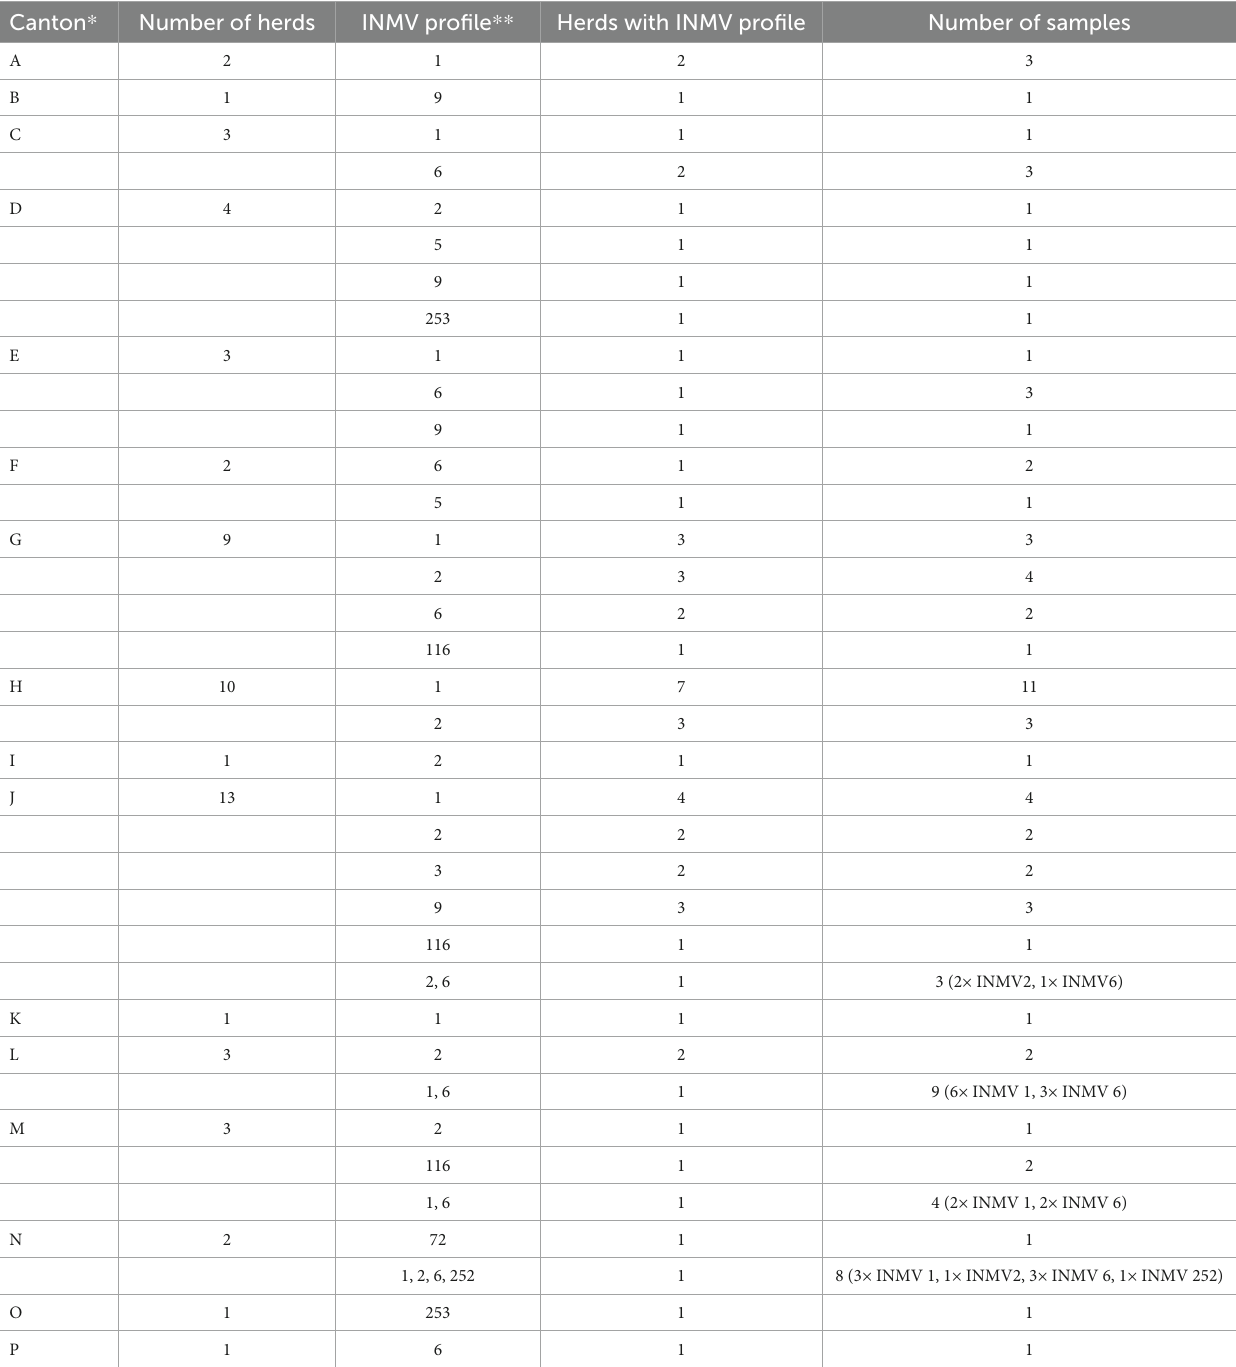
TABLE 2 Geographic distribution of 90 F57- and IS 900 -positive fecal samples from 59 herds originating from 16 Swiss cantons (A–P) in relation to the number of herds, INMV profile, herds comprising a specific INMV profile, and number of samples. Canton